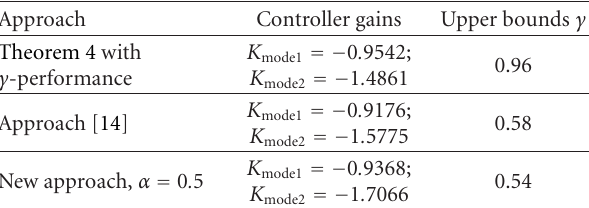
Table 3: Numerical